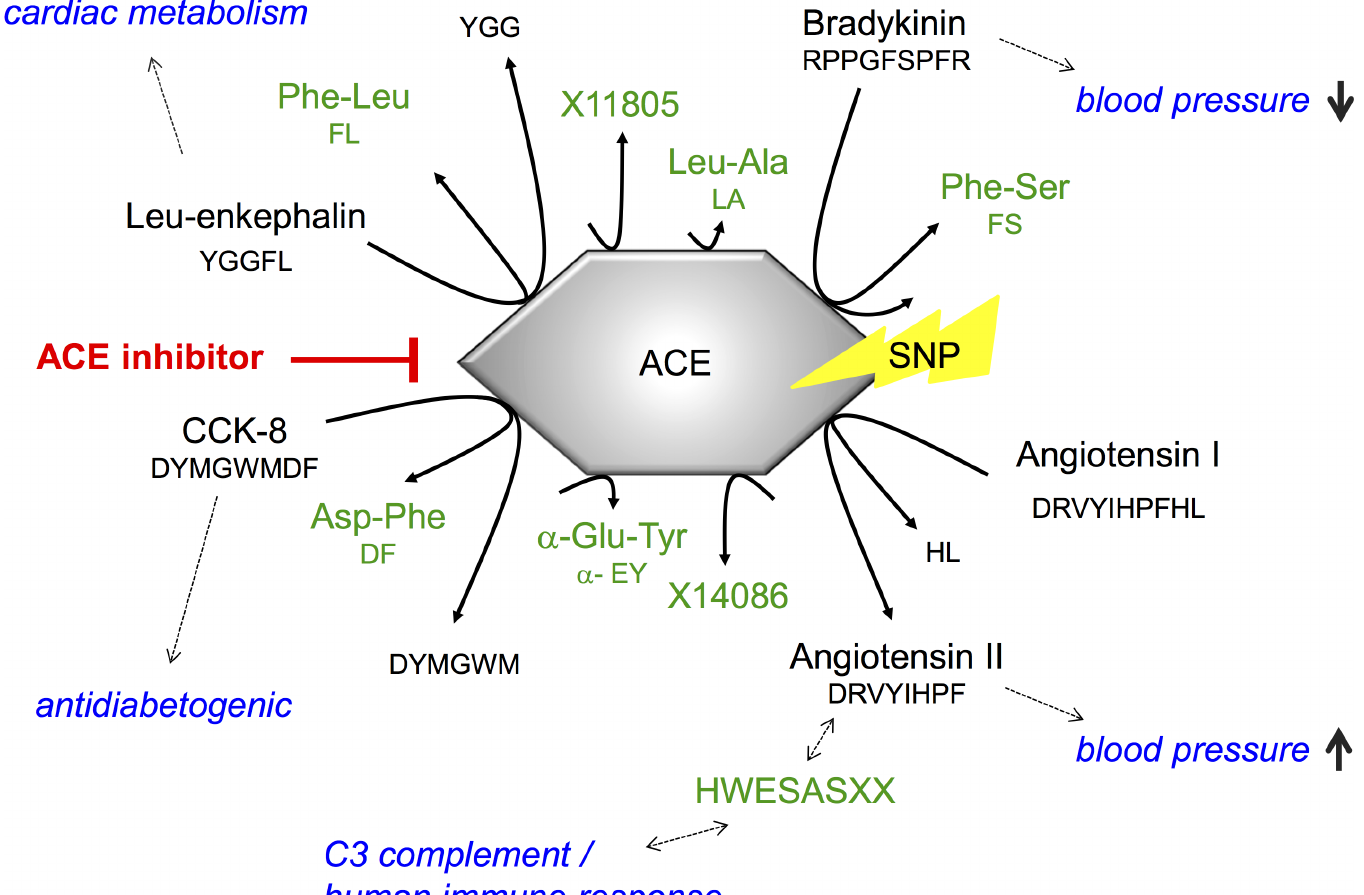
Fig 2. Summary of here discussed genotype dependent polypeptide cleavage catalyzed by ACE. Blue coloring: health effect of the respective polypeptide; green: measured metabolites.